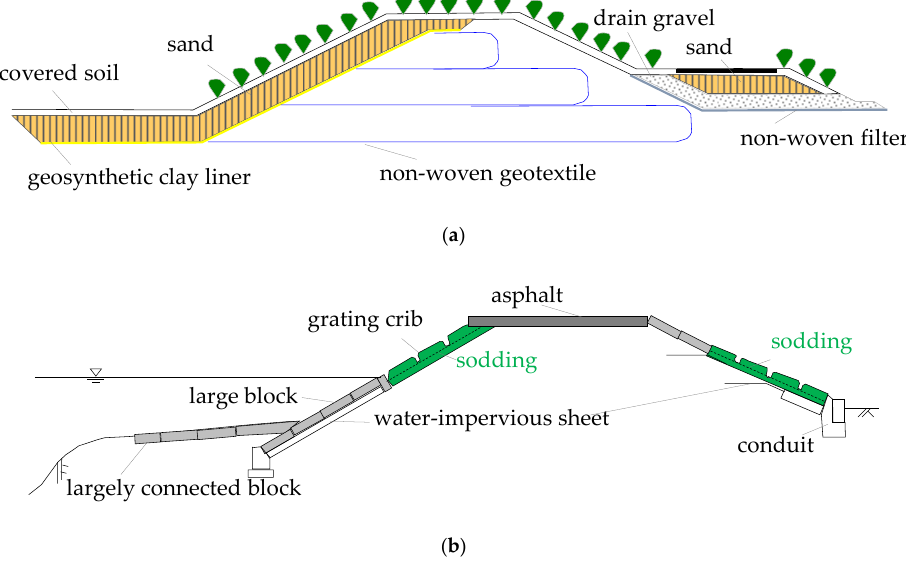
Figure 1. Examples of compound-type levees using artificial materials. ( a ) Levee reinforcement of the Oder River in Poland described in the International Levee Handbook (ILH) [5]; ( b ) armored levee on the Kakogawa River in Japan.